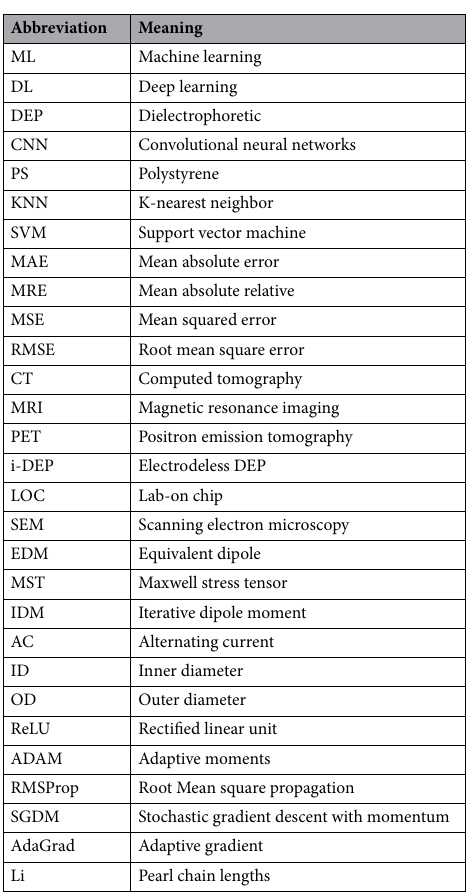
Table 1. A list of abbreviations and terms used in the